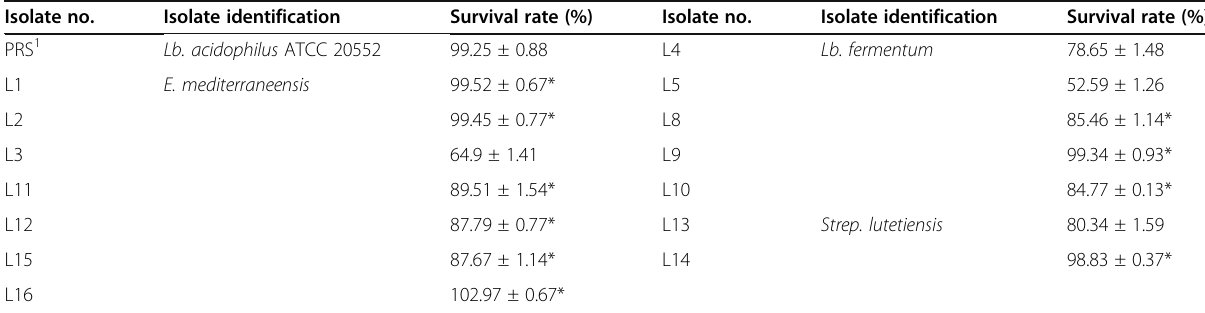
Table 4 Phenol tolerance of isolated LAB Isolate no. Isolate